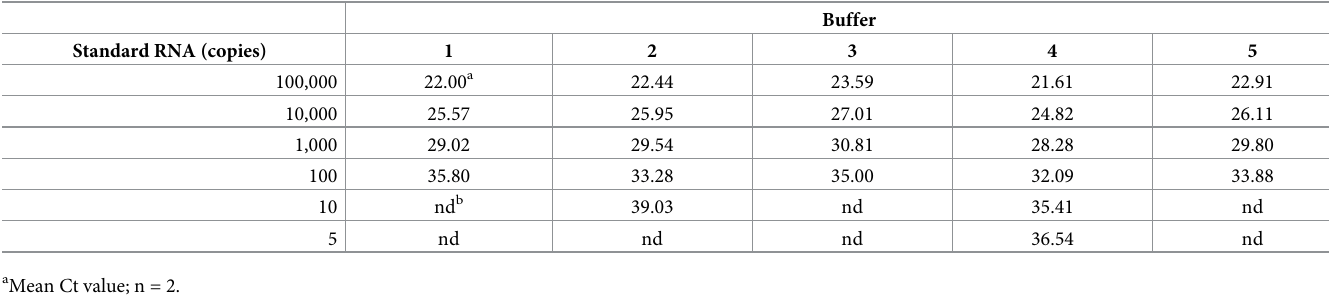
Table 3. The Ct values of the one-step real-time PCR with MM4 and M1pol Tth with standard RNA of varying copy numbers.